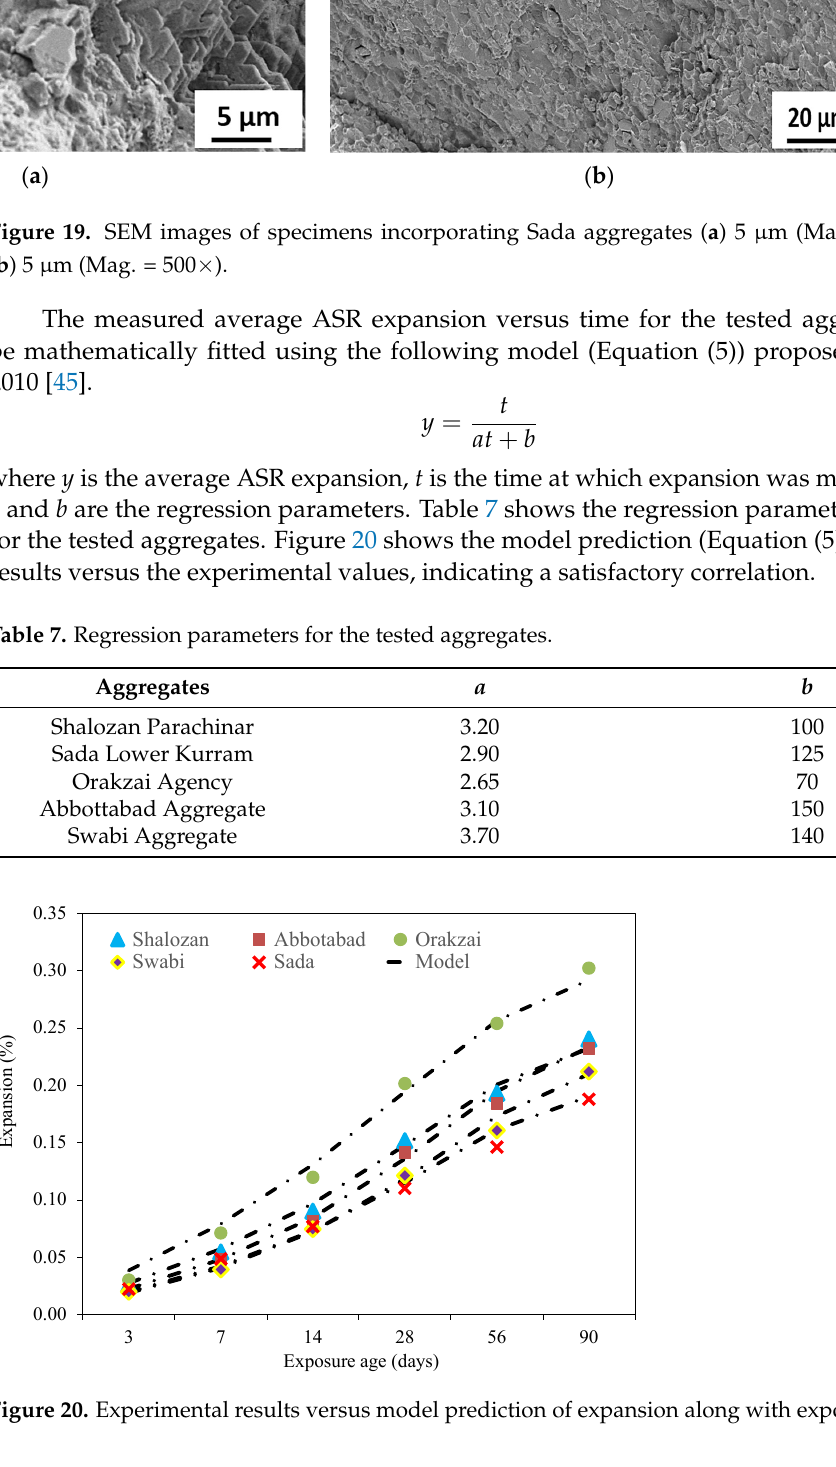
Figure 19. SEM images of specimens incorporating Sada aggregates ( a ) 5 µm (Mag. = 1.92K×) ( b ) 5 µm (Mag. = 500×).